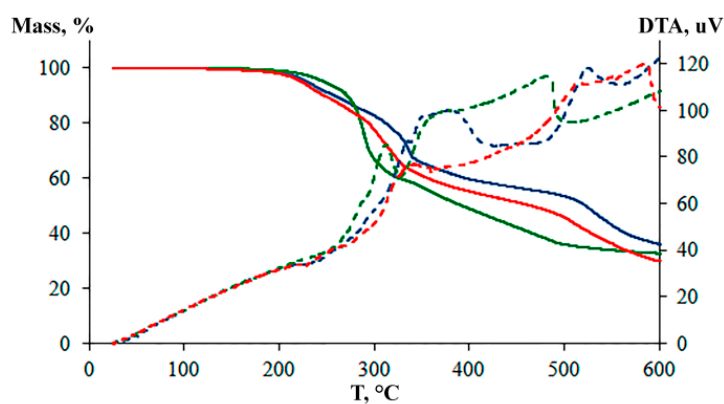
Figure 9. TG curves for 1 (blue line), 2 (green line) and 3 (red line). DTA curves are shown with dash lines.